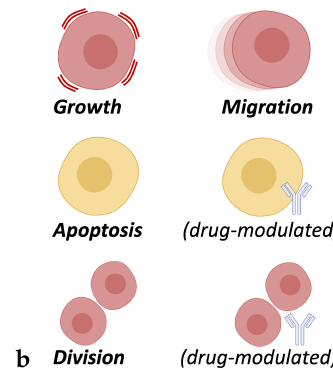
Figure 1. ( a ) Graphical representation of the MTT viability assay procedure: from cell seeding and treatment to reduction of yellow MTT to purple formazan crystals for tracking of the metabolic activity of viable cells to estimate the amount of cells survived after drug treatment; ( b ) agent-based model mechanisms accounted for in cell (agent) behaviour include cell growth, migration, division, and apoptosis. The latter two are also modulated by the presence of